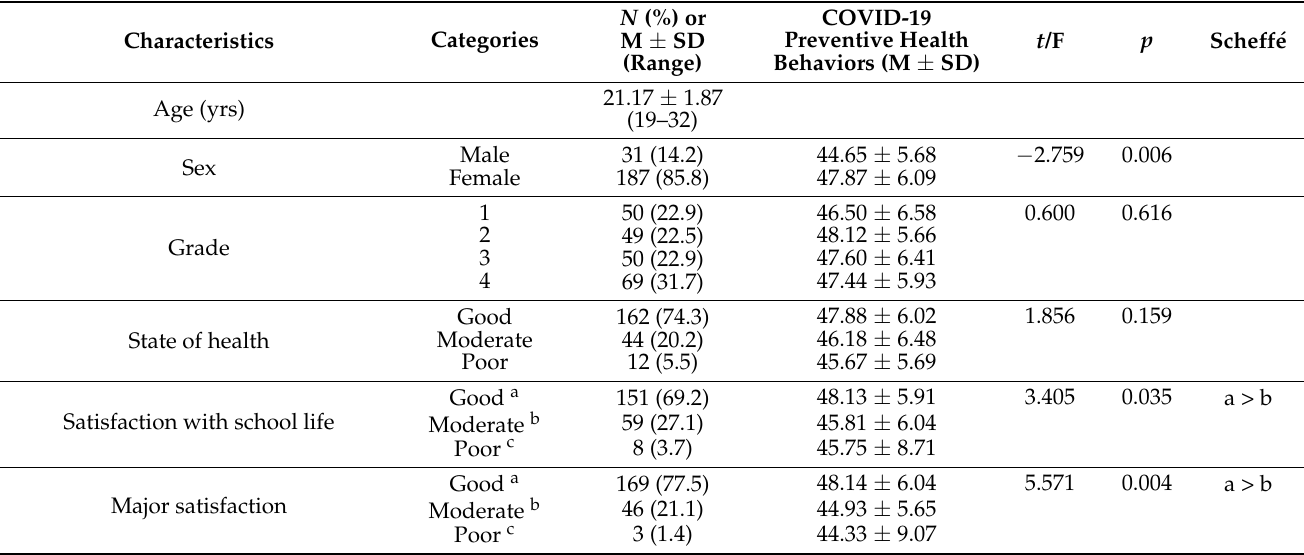
Table 1. Differences in COVID-19 preventive health behaviors by demographic